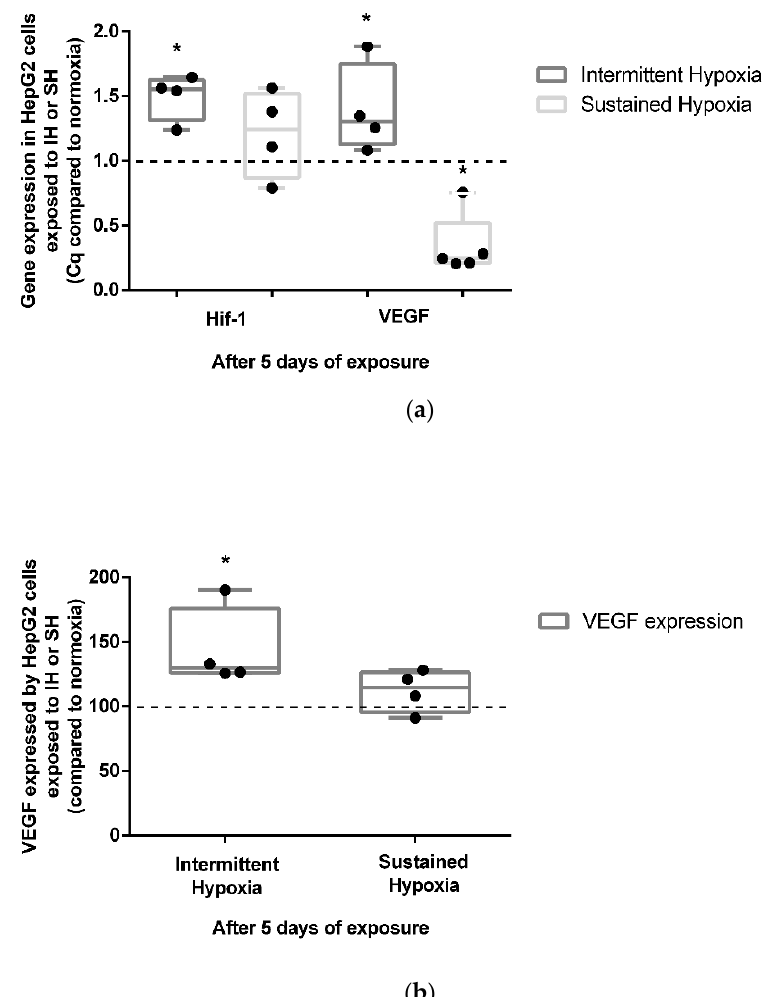
Figure 3. In vitro effects of IH and SH on HIF-1 α gene expression, and VEGF gene and protein expression. ( a ) Intermittent hypoxia is associated with an increase in HIF-1 α and VEGF gene expressions in HepG2 cells after 5 days of exposure. The levels of HIF-1 α and VEGF gene expression were measured by RT-QPCR; n = 3 independent experiments/group. * p < 0.05, Mann–Whitney U test. ( b ) VEGF expression increases in HepG2 cells after 5 days of IH but not SH exposure. The levels of VEGF protein in the cell’s supernatant were measured by ELISA; n = 3 independent experiments/group. * p < 0.05) Mann–Whitney U test.